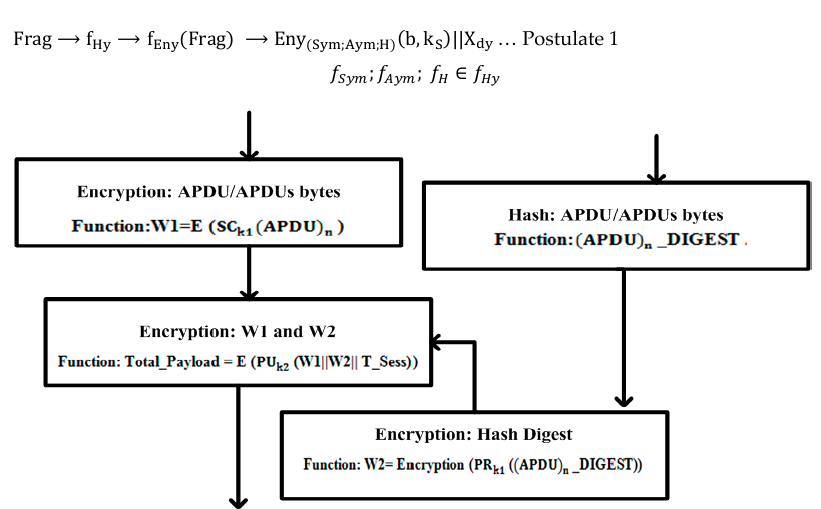
Figure 7. Encryption process: application-layer implementation.